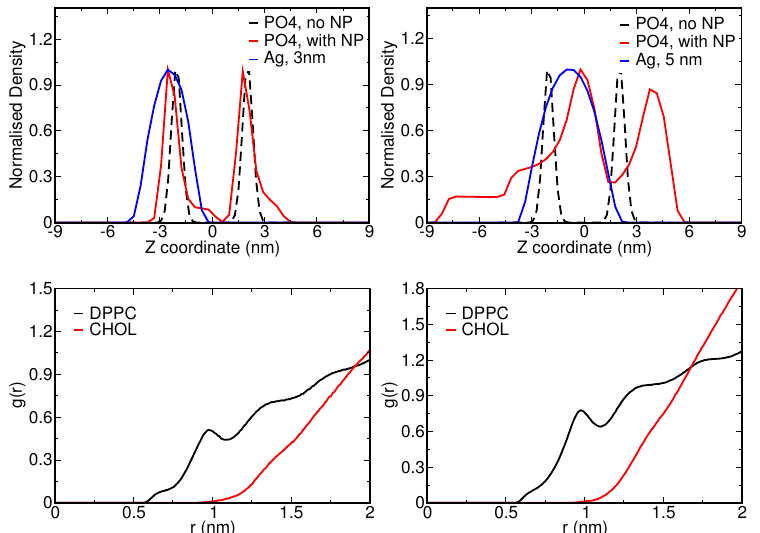
Figure 7. ( Top ) Normalized density profile for the PO4 CG bead of the DPPC, POPC and DOPC. Here, the black line represents the PO4 density when a CG NP is absent, the red line when a CG NP is present and the blue line represents the CG NP itself. ( Bottom ) Radial distribution functions of 3 nm ( left ) and 5 nm ( right ) Ag CG NP with cholesterol (red) and DPPC (black). In the procedure, the closest distance to the NP surface is